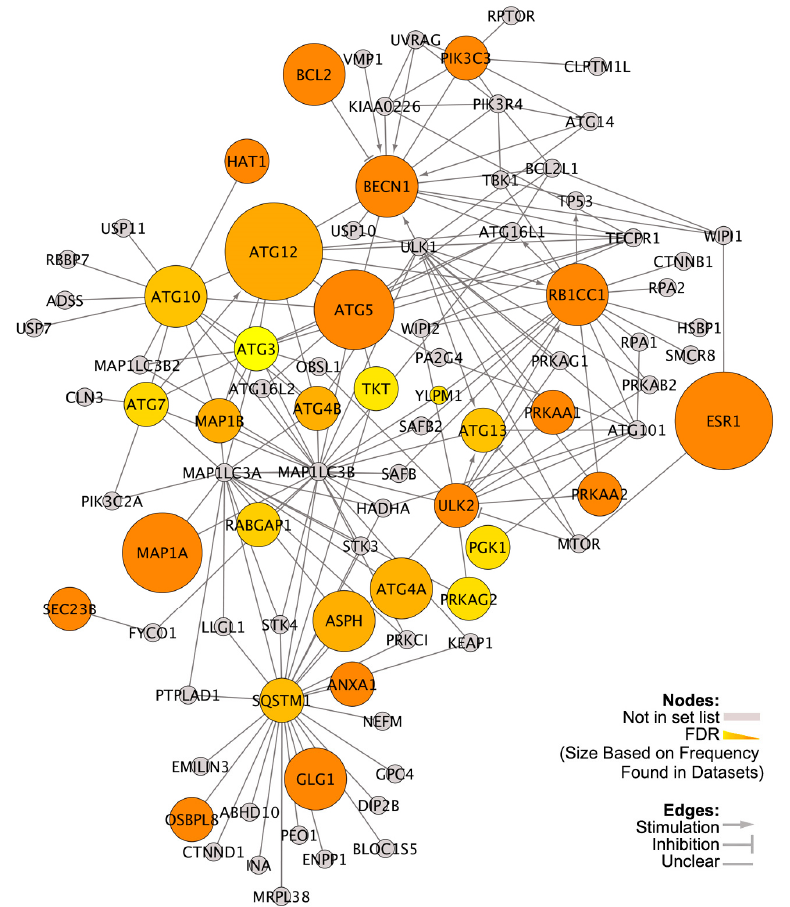
Figure 2. Protein–protein interactions among differentially expressed genes (DEGs) in the Autophagy Regulatory Network (ARN) [35] between breast cancers expressing higher and lower VDR. ER+ mammary tumors in GSE-17705 [31], GSE-12093 [32], GSE-6532 [33] and GSE-1379 [34] datasets were used. Colored circles are DEGs. Node color represents FDR value; the darker the color the smaller the FDR. Node size denotes the frequency of a gene differentially expressed in GEO datasets, e.g., smallest nodes are DEGs in 1 dataset, while largest nodes are DEG in 4 datasets. VDR expression and breast cancer survival and autophagy-related gene expression in tamoxifen-treated patients. Interactions among the 30 differentially expressed autophagy genes are shown in Figure 2. ATG12, ESR1, BCL2, PIK3C3, and PRKAG2 were differentially expressed in all four datasets. ATG12, Bcl-2, and PIK3C3 are central autophagy regulators [41]. ESR1 can regulate each of these genes [11]. PRKAG2 is an AMPK family member; AMPK is a master regulator of cellular energy homeostasis and activates autophagy. Other VDR linked autophagy genes were ATG7, ULK2 (ATG1B), BECN1, ASPH, ANXA1, HAT1, PGK1, TKT, and GK1 that induce autophagy. Other DEGs included ATG3, ATG4A, ATG4B, ATG5, ATG10, ATG13, MAP1A, MAP1B, RABGAP1, and RB1CC1/ATG17 that are directly related to the process of autophagosome formation. Autophagy cargo receptor marker p62 (SQSTM1) was also differentially expressed. Moreover, some DEGs were AMPK family members (PRKAA1 and PRKAA2). Other DEGs identified from the Autophagy Regulatory Network included GLG1, OSBPL8, SEC23B, TKT and YLPM1. Taken together, these results show that VDR affects autophagy at multiple